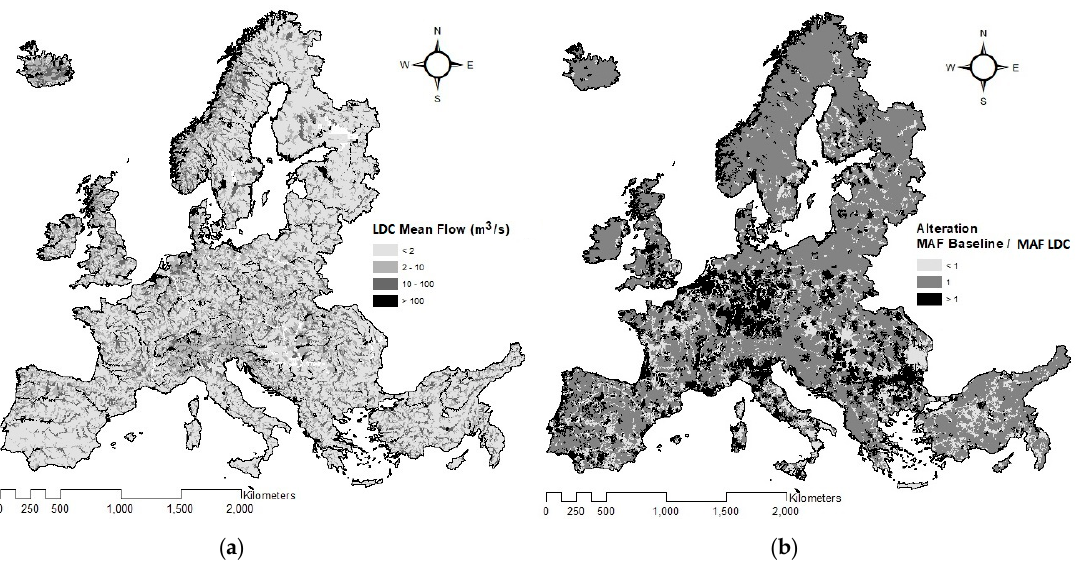
Figure 3. ( a ) Mean annual flow (MAF) (m 3 /s) of the 10-y period under the least disturbed conditions (LDC) scenario, i.e., the scenario of the historic climate 2001–2010 with the least disturbed conditions. ( b ) Alteration of baseline MAF (2001–2010 with modified conditions) from the LDC MAF, expressed as MAF (baseline)/MAF (LDC). Ratios below unity indicate decrease in flow, values equal to unity show no alteration and values above unity show increase from the least disturbed conditions. Reduction is depicted with lighter colors and is observed mostly in parts of the Mediterranean countries. Increase in flows (ratio > 1) is found in Central and South–Eastern Europe. Very large parts all across the continent and especially in the North remain unaltered with respect to annual river flows (ratio = 1).